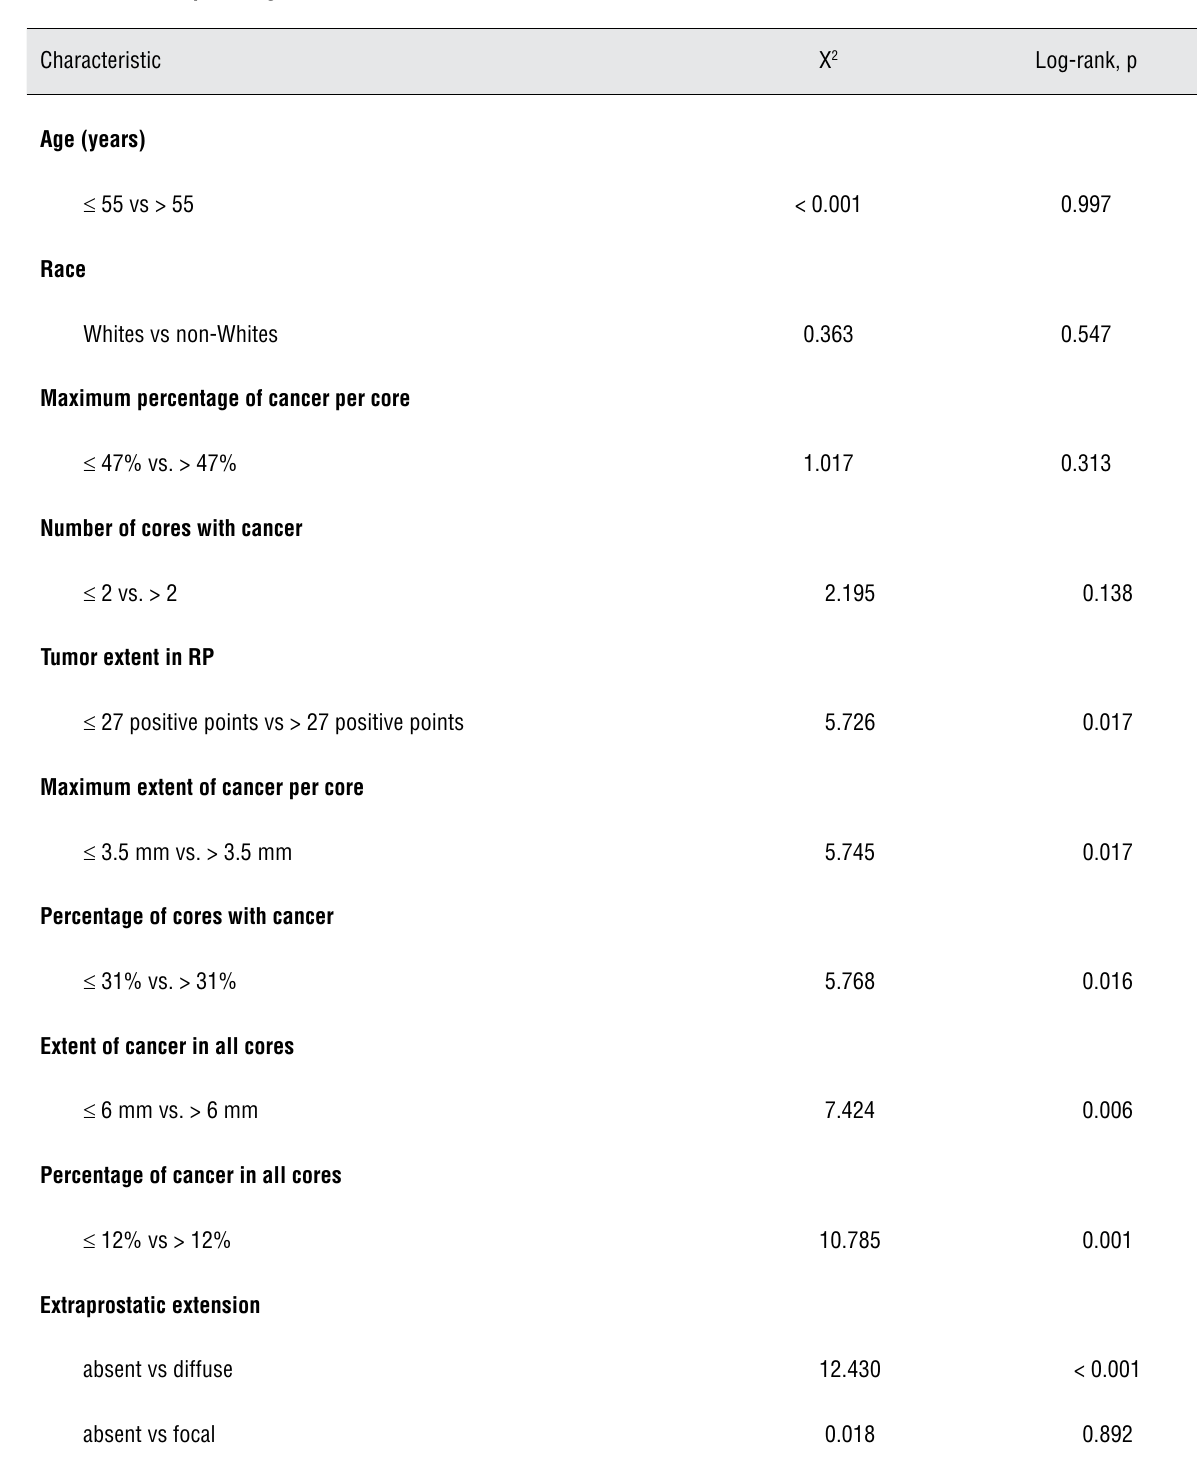
Table 2 - Kaplan-Meier product-limit analysis for time to biochemical recurrence following radical prostatectomy according to several clinicopathologic